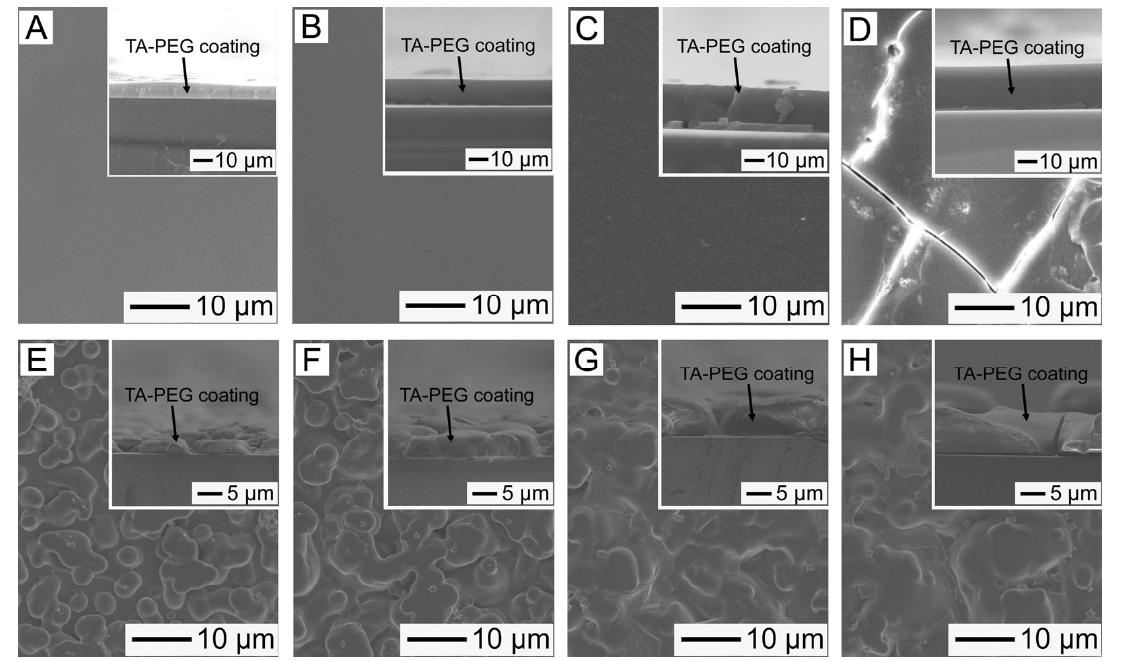
Figure 3. ( A – D ) SEM images of the surface morphologies of the PMMA substrates incubated for 10 min with the TA–PEG emulsions (5 mg/mL PEG with M W = 100 kDa; 2 M NaCl) containing different concentrations of TA: ( A ) 2.5 mg/mL, ( B ) 5.0 mg/mL, ( C ) 7.5 mg/mL, and ( D ) 10 mg/mL. ( E – H ) SEM images of the surface morphologies of the PMMA substrates incubated for 10 min with the TA–PEG emulsions (0.5 mg/mL PEG with M W = 200 kDa; 2 M NaCl) containing different concentrations of TA: ( E ) 2.5 mg/mL, ( F ) 5 mg/mL, ( G ) 7.5 mg/mL, and ( H ) 10 mg/mL. The cross-sectional SEM images are shown in the insets.